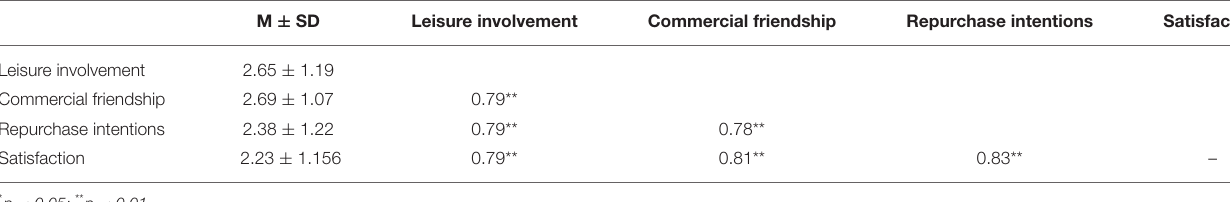
TABLE 2 | Summary of the descriptive statistics and correlation analysis results among the variables.